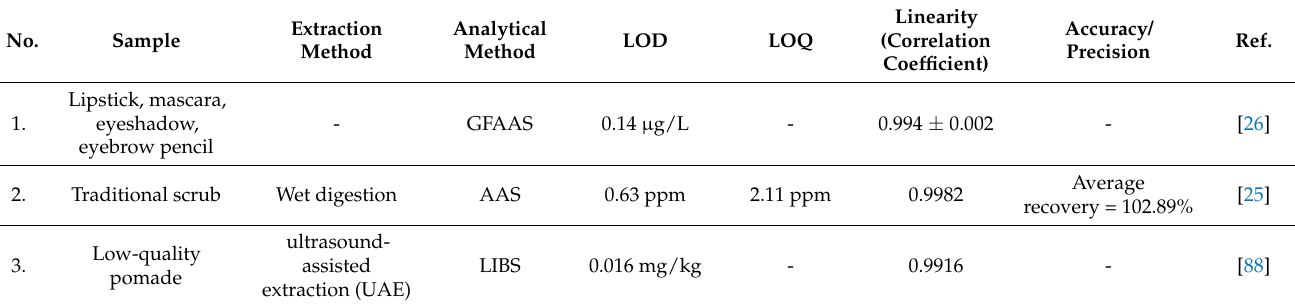
Table 4. Analytical method for determining cadmium in